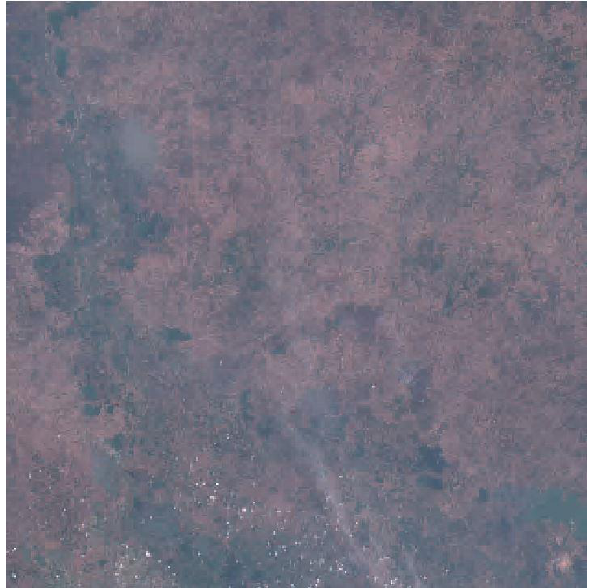
Figure 3: Hazy preview.